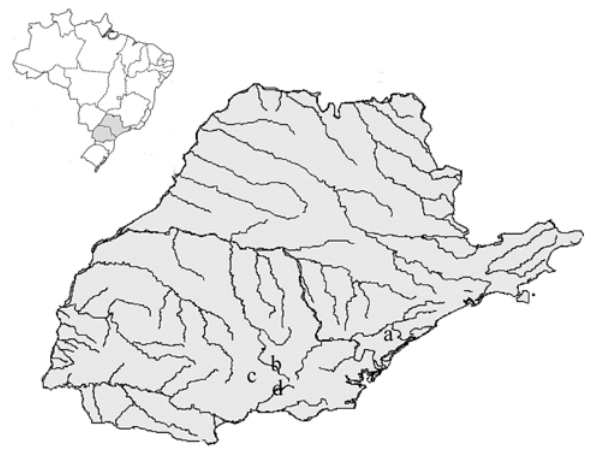
Figure 1 - Map of Brazil showing the collection sites of Hoplias malabaricus in the states of São Paulo and Paraná: (a) Ribeira, (b) Tibagi, (c) Ivaí, and (d) Iguaçu